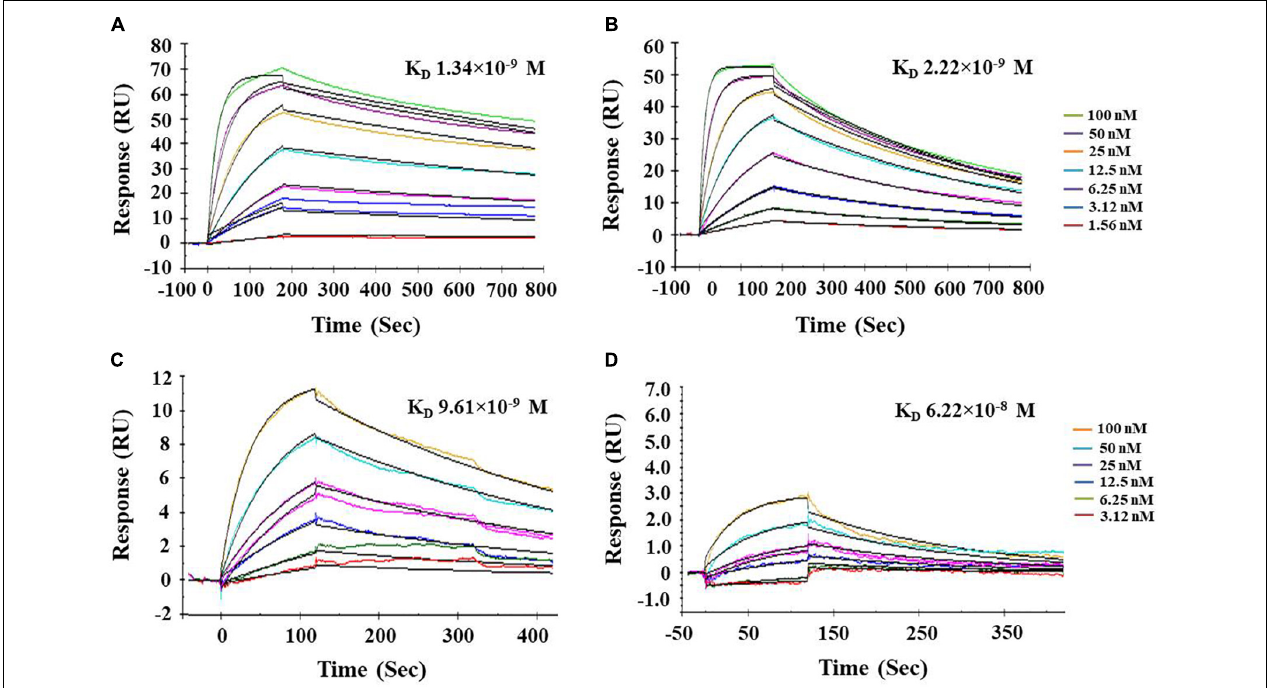
FIGURE 4 | Biacore surface plasmon resonance (SPR) analysis of PnBBI. Sensogram plots generated by SPR kinetic analysis demonstrate the association and dissociation characteristics between immobilized ligand (PnBBI) and analytes, bovine (A) trypsin and (B) chymotrypsin; Competitive binding studies between ligand and analytes where (C) Chymotrypsin (500 nM) was captured on PnBBI ligand and trypsin was passed through as an analyte and (D) Trypsin (500 nM) was captured on PnBBI ligand and chymotrypsin was passed over as an analyte. A range of trypsin/chymotrypsin concentrations (1.56, 3.12, 6.25, 12.5, 25, 50, and 100